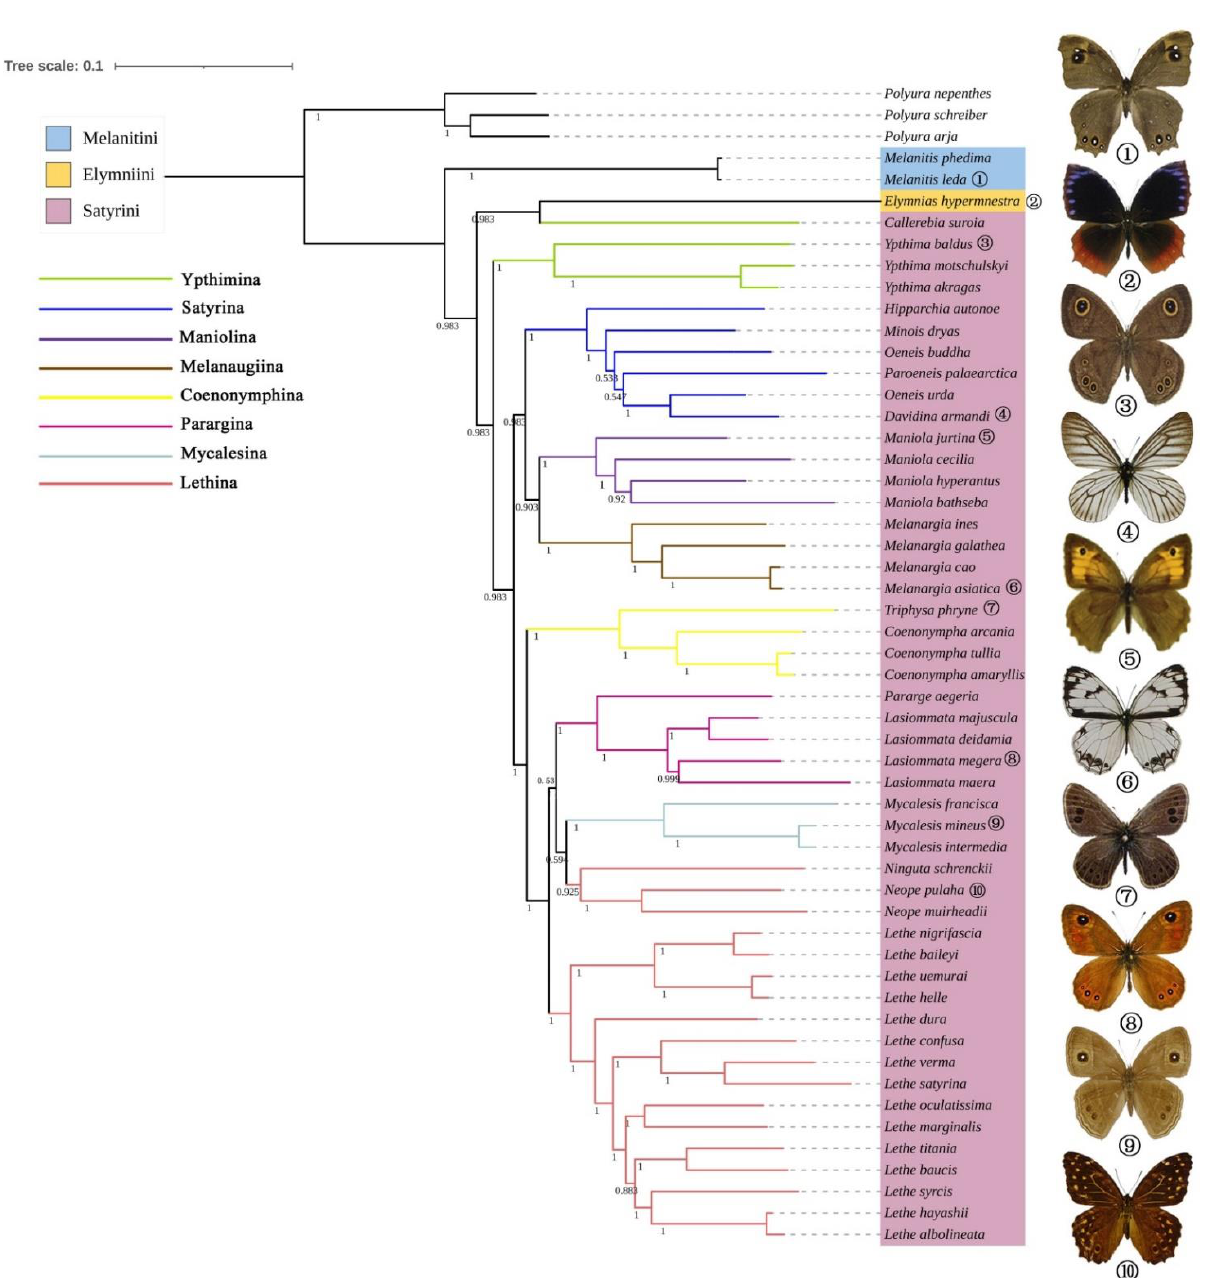
Figure 6. Phylogenetic tree inferred from nucleotide sequences of 13 PCGs and two rRNA genes using the BI. Posterior probabilities are indicated on branches.